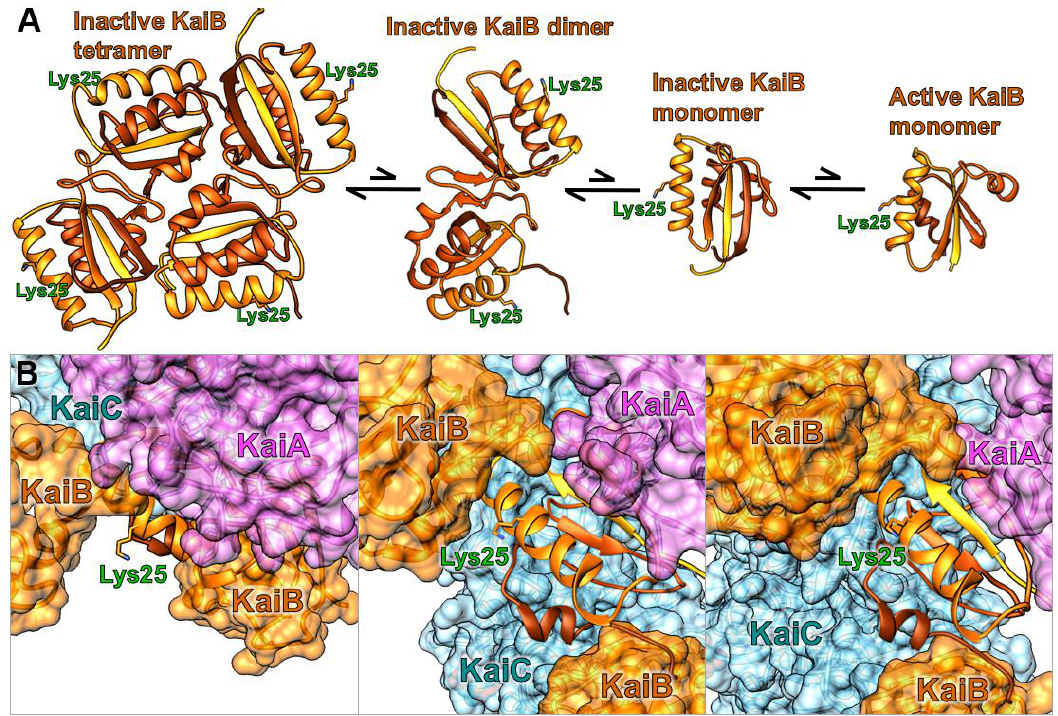
Figure 2. Fluorescence labeling site lysyl 25 on KaiB in relation to ( A ) KaiB’s four different free states and ( B ) ternary KaiABC complex shown in multiple orientations, with KaiA (purple), KaiB (orange), and KaiC (blue) [16].